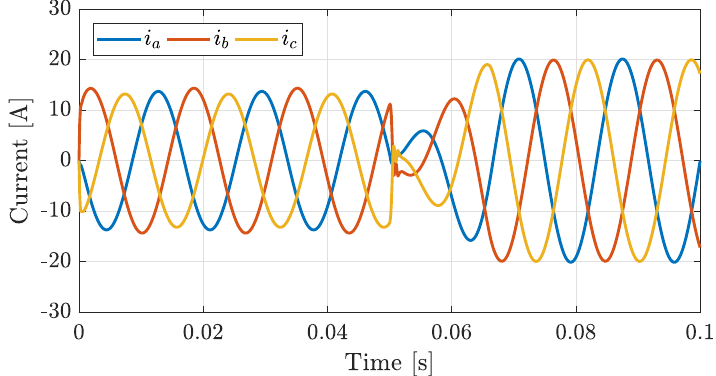
Figure 8. Simulation of three optimal controllers designed to face a unbalanced linear loads